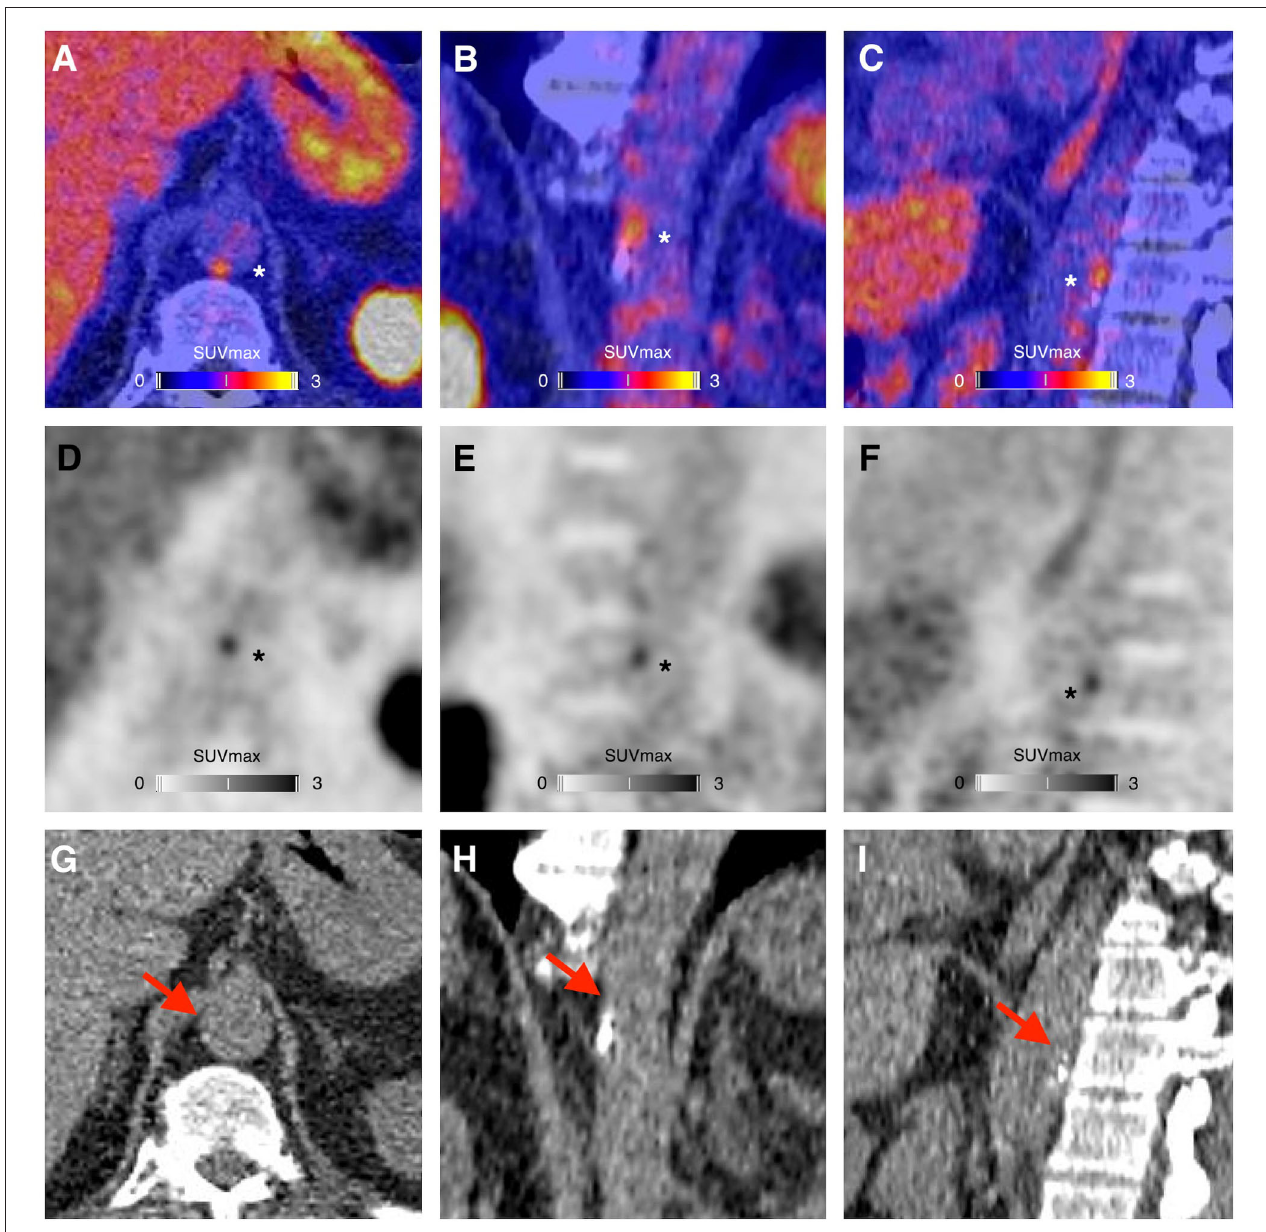
FIGURE 3 | PET/CT (A–C) , PET (D–F) , and CT (G–I) images showing a focus of 68 Ga-NODAGA-RGD arterial uptake (asterisks), in the periphery of a calcified atherosclerotic lesion (red arrows), in the wall of the abdominal aorta of a 63-year-old man who had a myocardial infarction with ST elevation 3 months before PET imaging. The risk factors of the patient were resumed to current tobacco use and family history of early coronary artery disease. At the time of the PET imaging the patient was treated with high intensity statin therapy, aspirin, ticagrelor, beta-blockers and an angiotensin-converting enzyme inhibitor, and was advised to adopt a healthy diet and to engage in regular physical